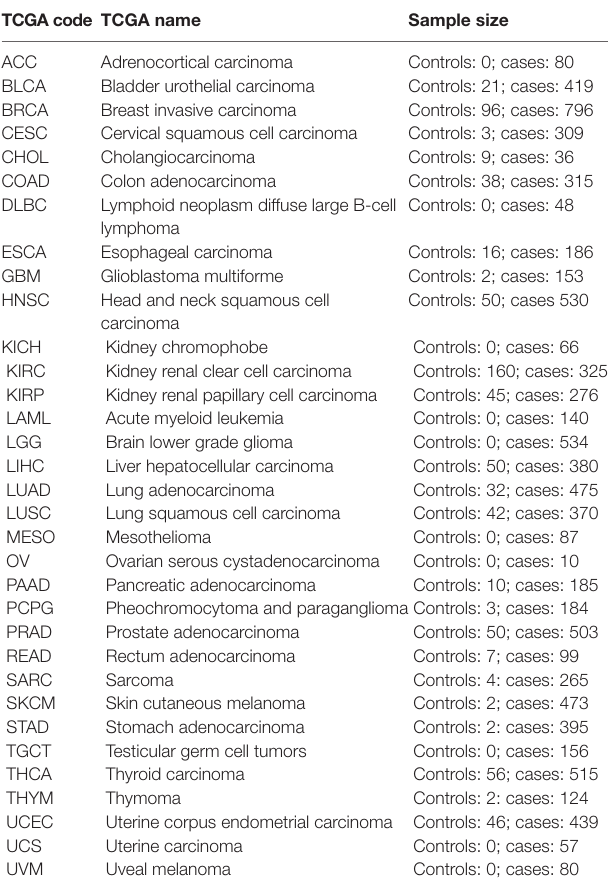
TABle 3 | The Cancer Genome Atlas